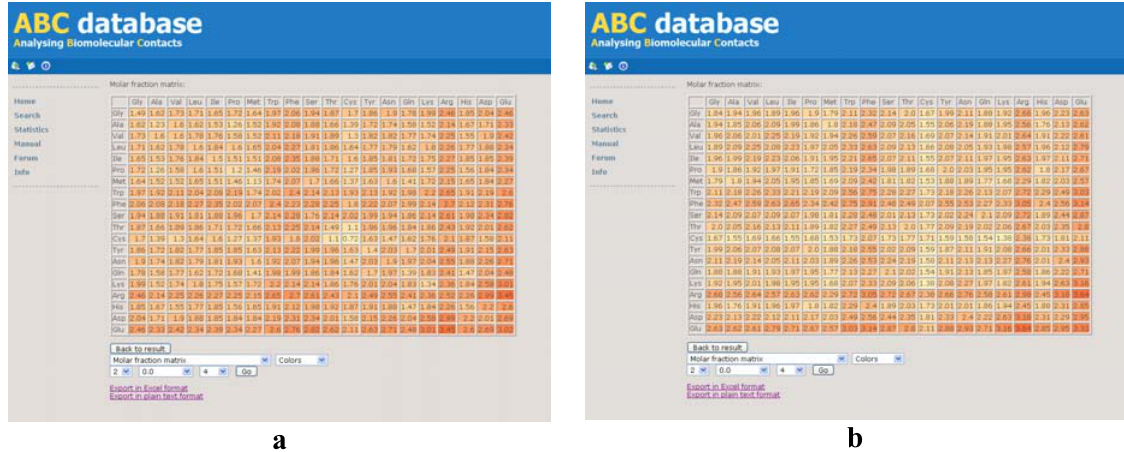
Figure 3: Scoring matrices calculated by ABC. The 20x20 matrix contains the pairing propensities of amino acids with each other. The values are normalized according to the